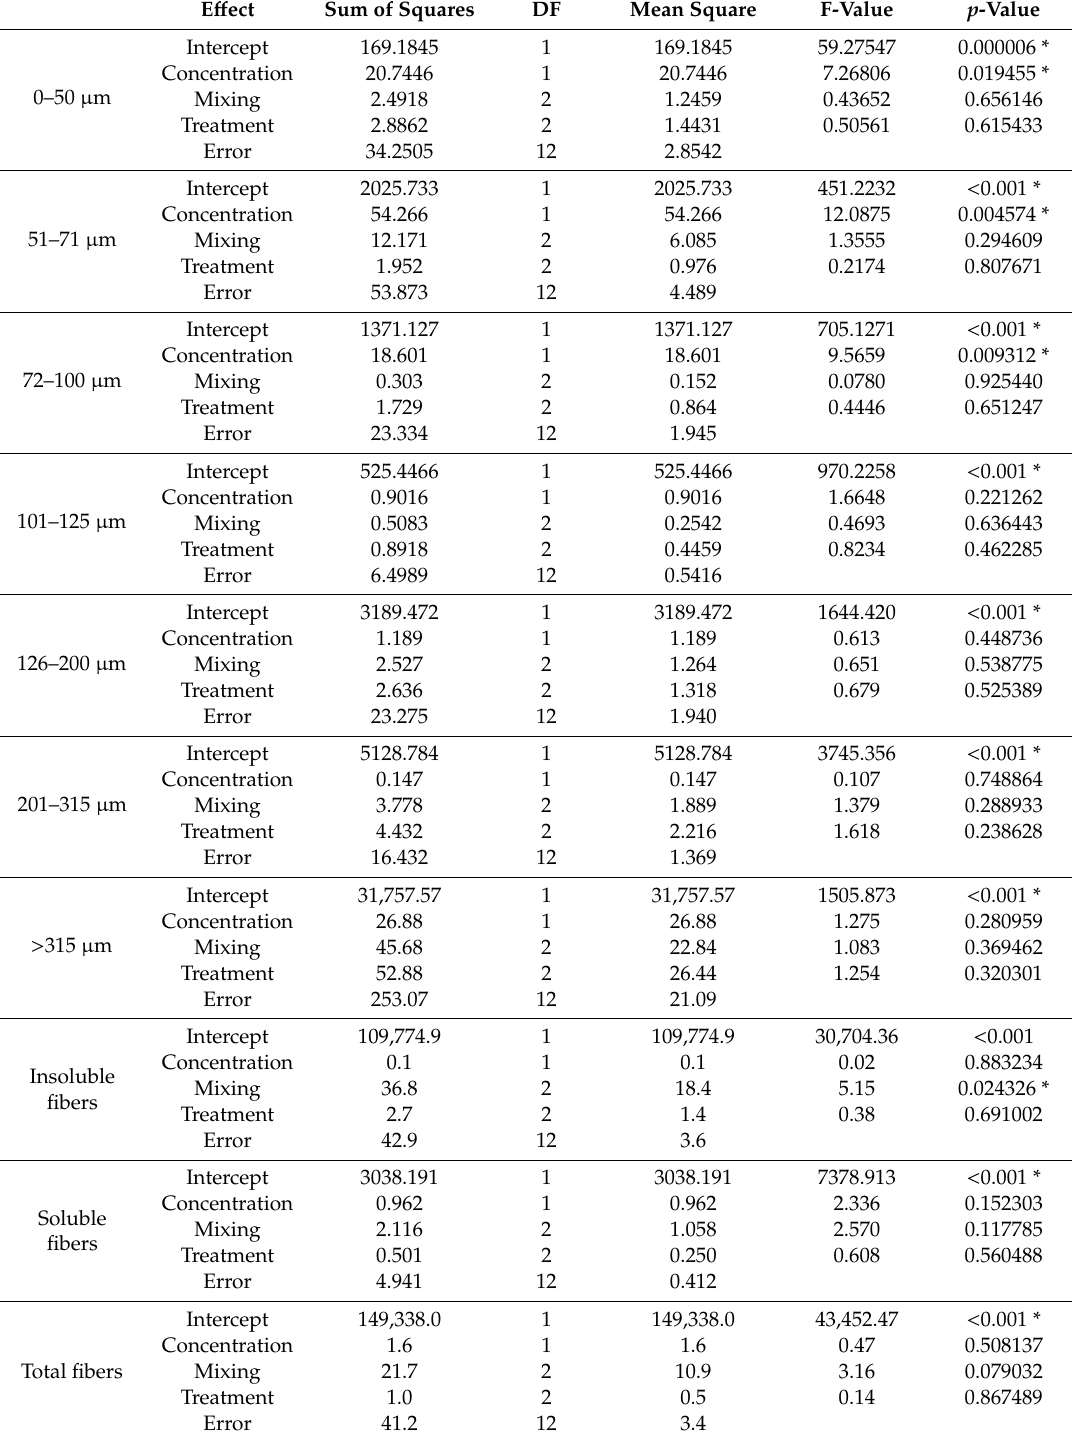
Table 2. Main e ff ects analysis of